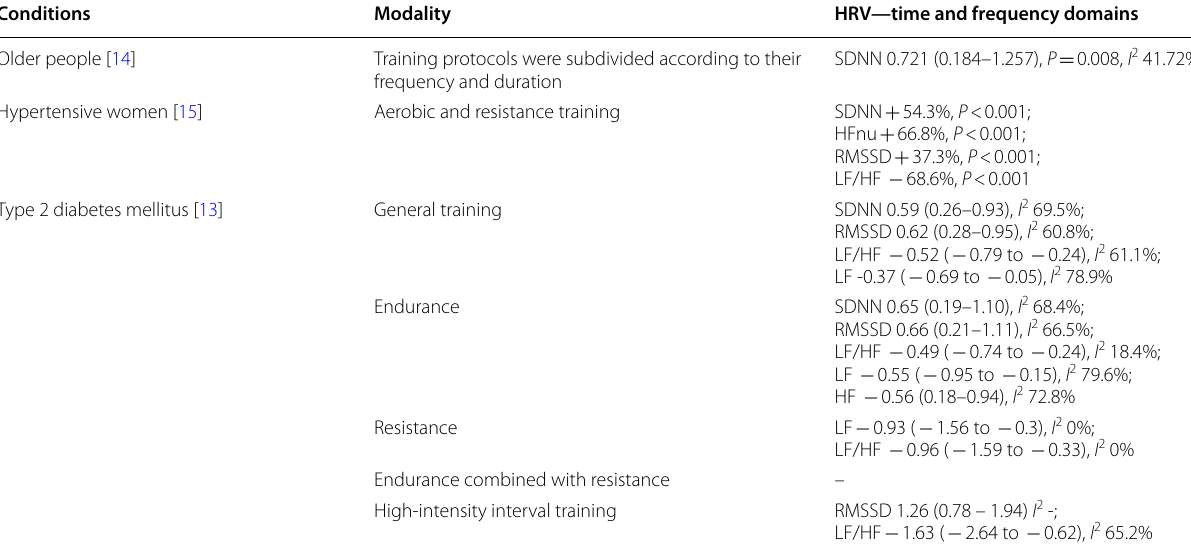
Table 2 Effect of physical training on heart rate variability